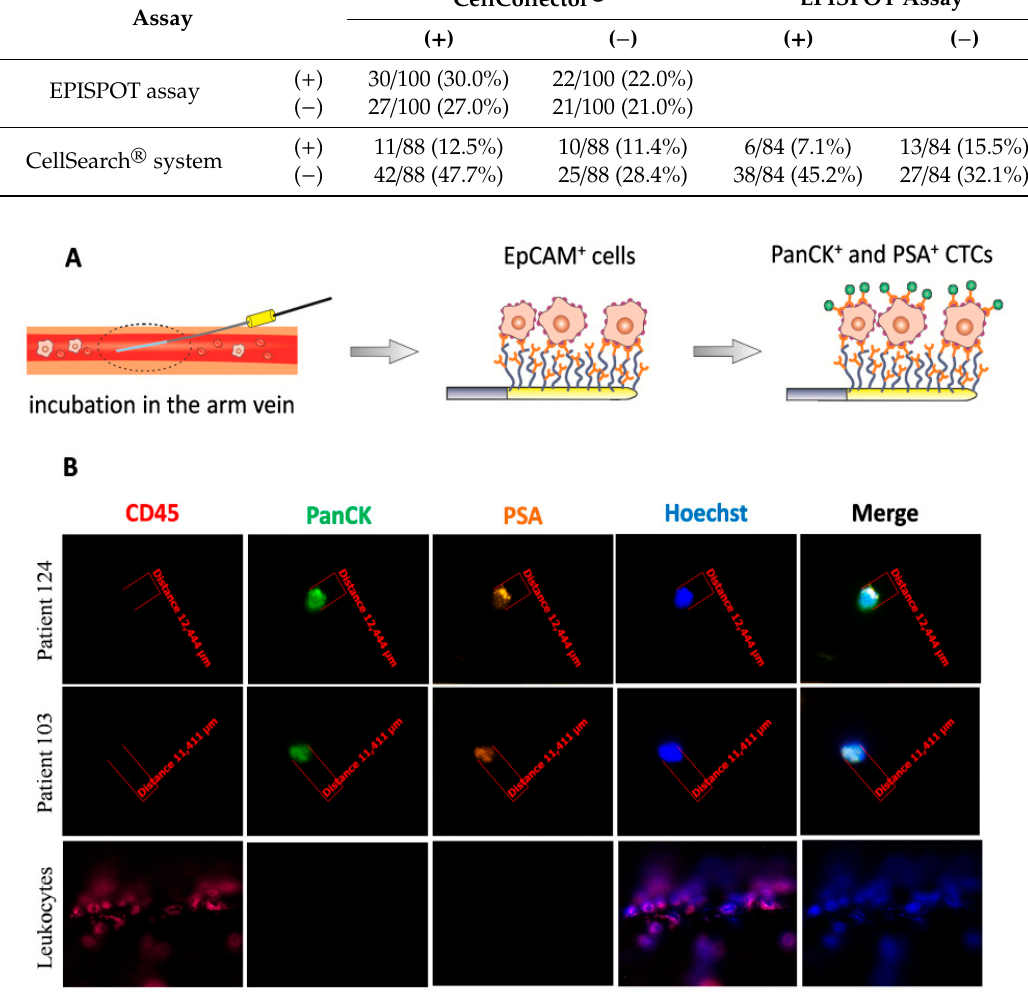
Figure 3. Detection of CTCs captured by the CellCollector ® in vivo system. ( A ) Procedure of the CellCollector ® detection. After 30 min incubation in patient’s arm vein, removal of the device together with captured EpCAM + cells, immunostaining of isolated cells with anti-panCK, anti-PSA, anti-CD45 antibodies and Hoechst nuclear staining for detection of CTCs. ( B ) Representative images of CTCs isolated in vivo and non-specifically bound leukocytes (CD45-positive). CTCs were identified according to the following criteria: panCK-positive (green), CD45-negative (red) and optionally, PSA-positive (orange), nucleus stained with Hoechst 33258 (blue). Images were obtained using a fluorescent microscope (Carl Zeiss, Axio Imager 2, 20 × ) and analyzed with the Carl Zeiss, Axio Vision 4.8 software.